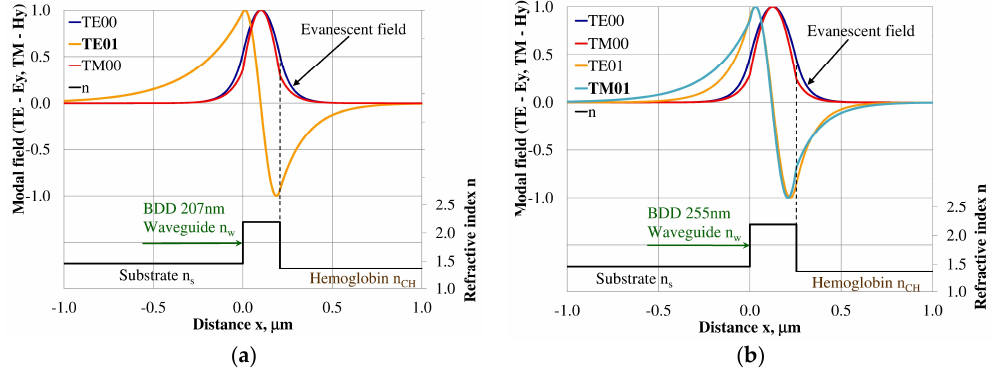
Figure 9. The modal field distribution in the multi-mode BDD-based waveguide: ( a ) TE01 for maximum dN eff /dn cH , and ( b ) TM01 for maximum dN eff /dn cH .